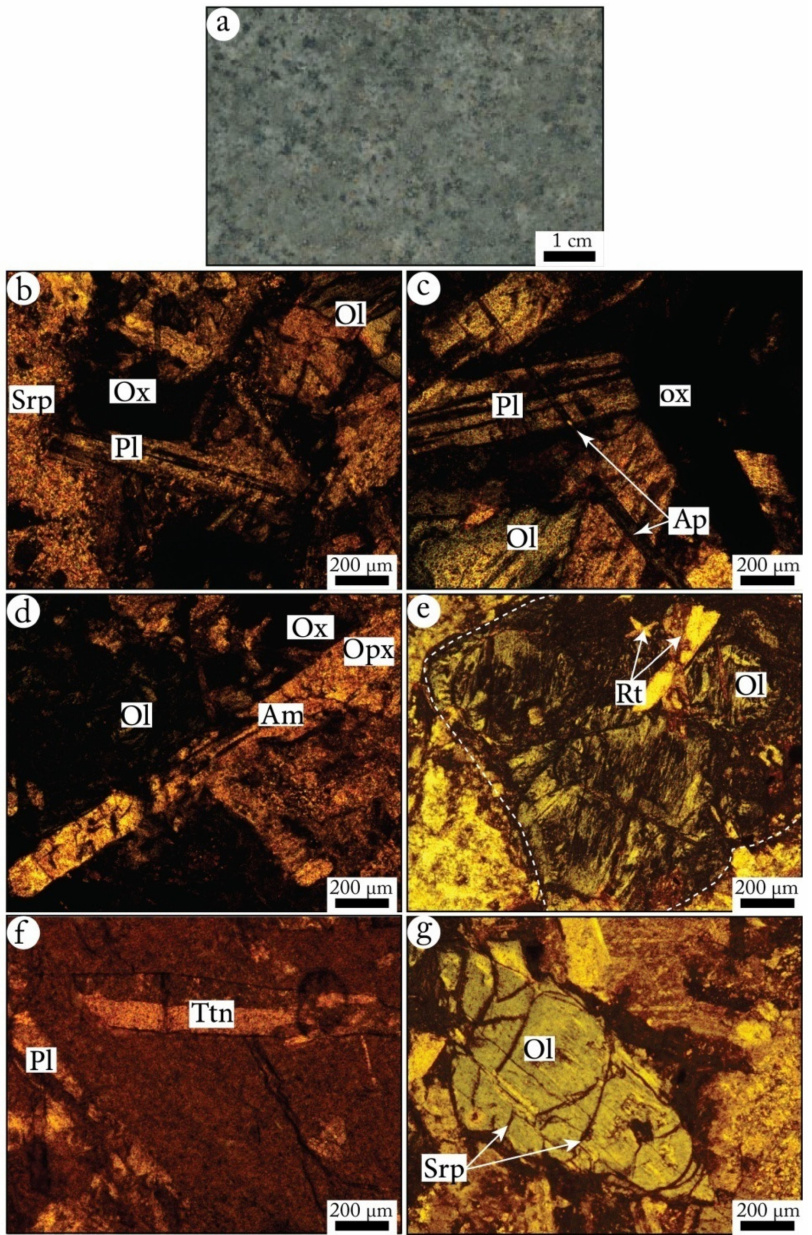
Figure 10. Samples of olivine-bearing gabbros. ( a ) Macroscopic view and ( b – g ): microphotographs of olivine-bearin gabbros (transmitted light-crossed nicols). Sericitized (Ser) plagioclases (Pl), amphibole (Am), orthopyroxene (Opx), serpentinized (Srp) olivine (Ol), Titanite (Ttn), apatite (Ap), rutile (Rt) and oxides